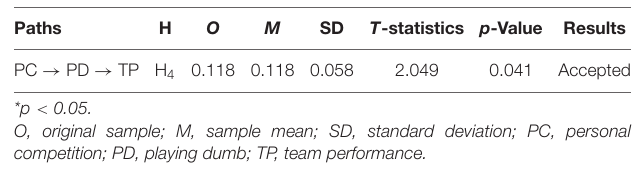
TABLE 8 | Indirect